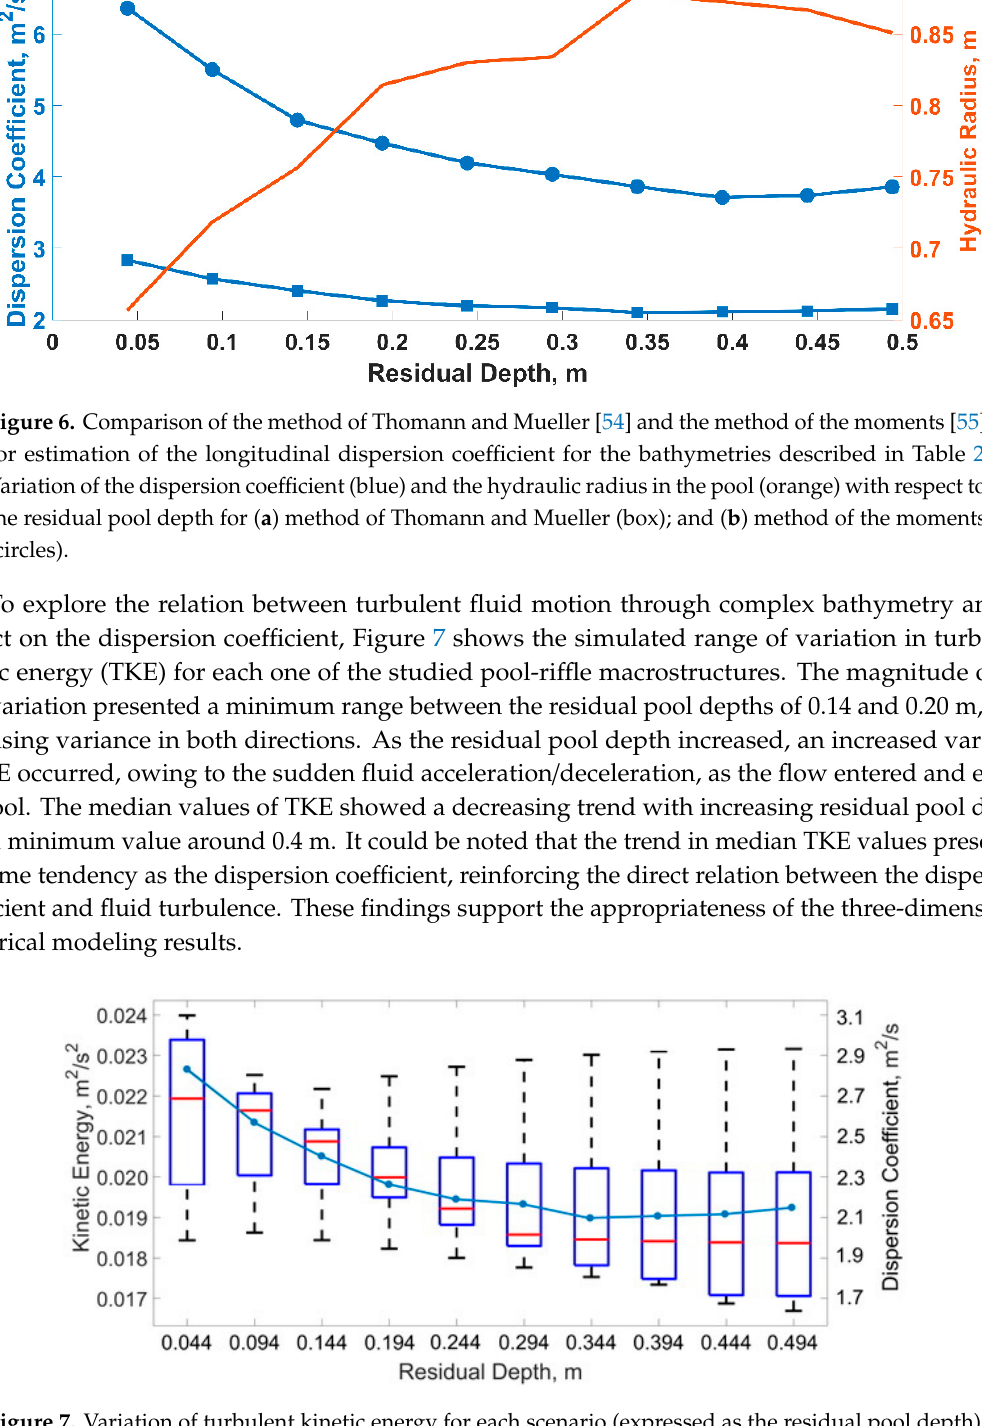
Figure 7. Variation of turbulent kinetic energy for each scenario (expressed as the residual pool depth).